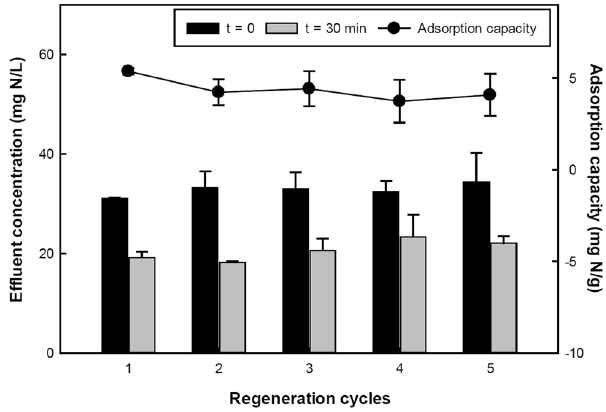
Figure 2. NH 4 –N concentrations before and after sorption, and sorption capacity of the PAA hydrogels as a function of sorption-desorption cycles. Sorption conditions: C 0 = 33 mg N/L, Contact time = 30 min, T = 23 °C, pH = 7.0. Error bars show the standard deviation from triplicate